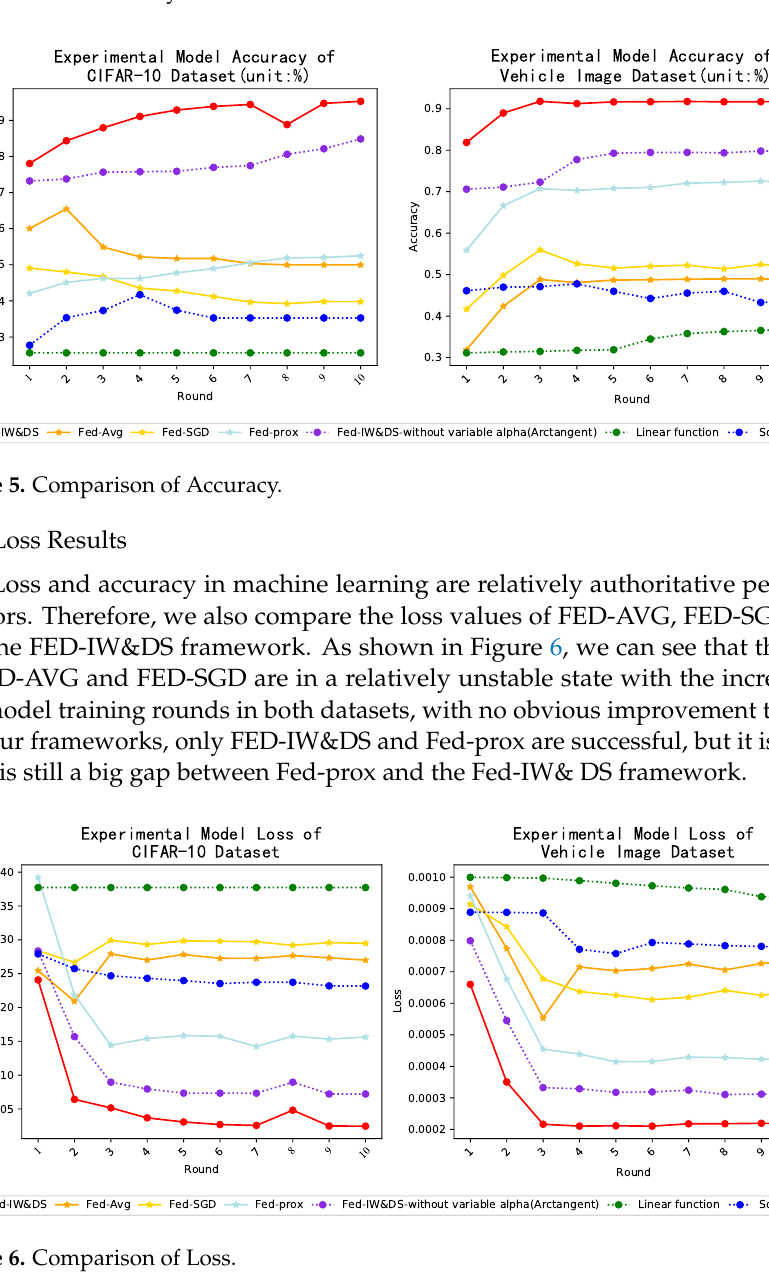
Figure 6. Comparison of